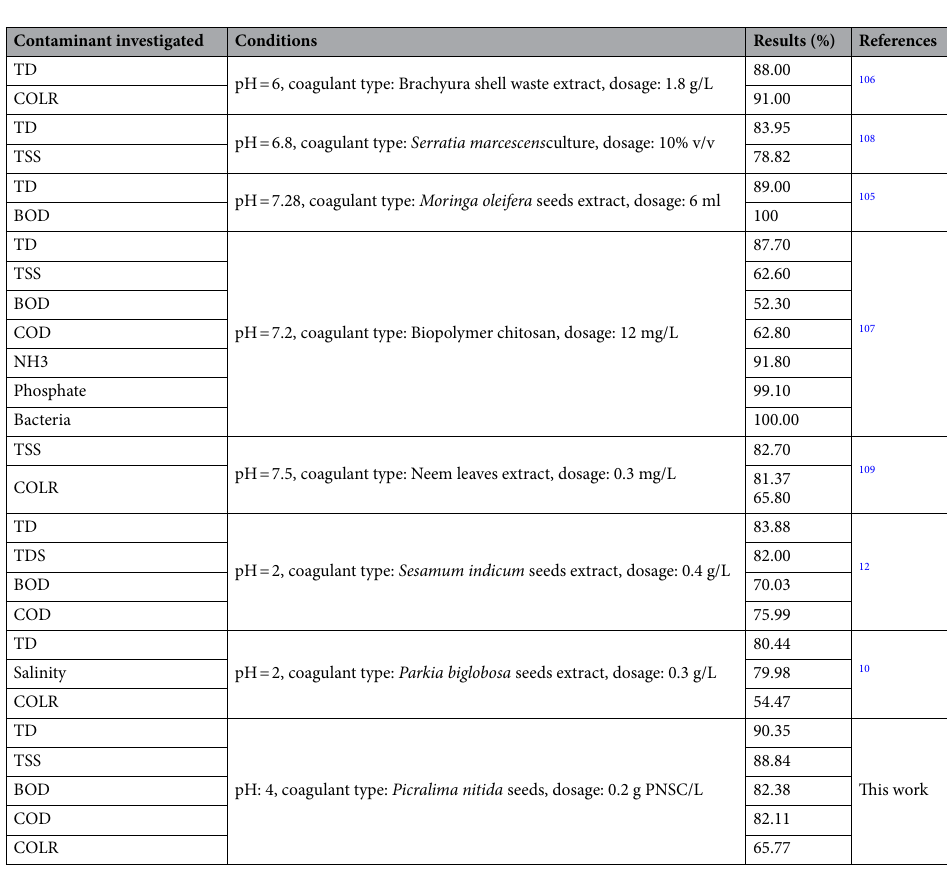
Table 6. Comparative analysis of PNSC with other coagulant sources on